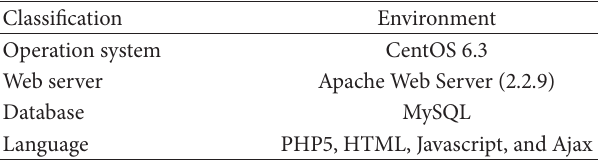
Table 1: Implementation